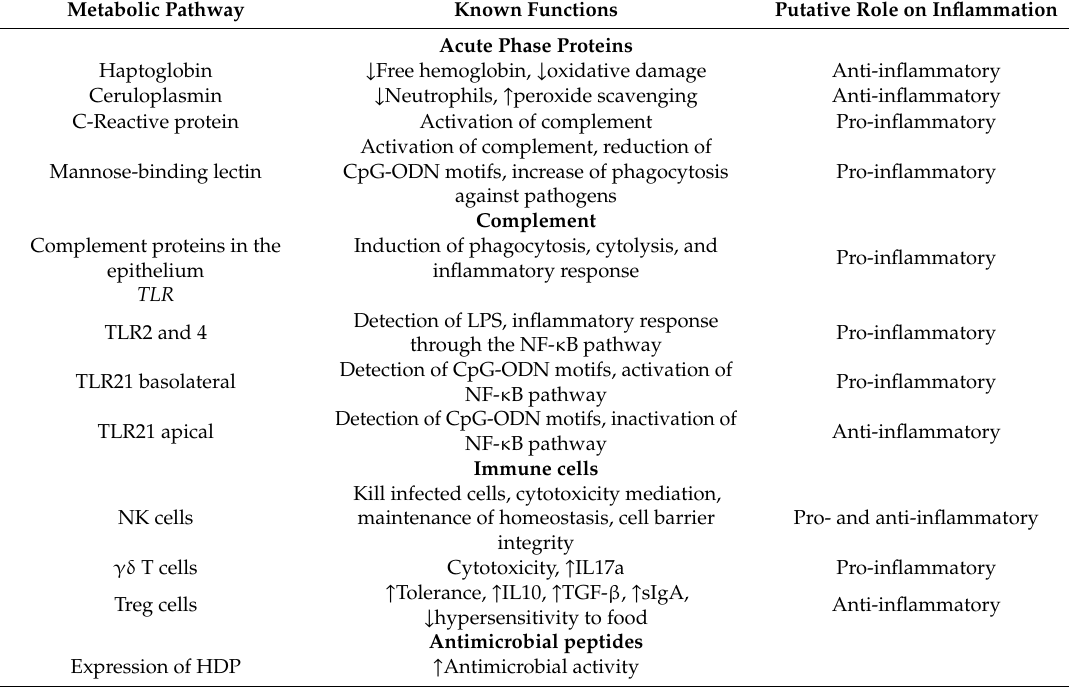
Table 1. Putative immune pathways susceptible to be modulated by probiotics but not demonstrated in